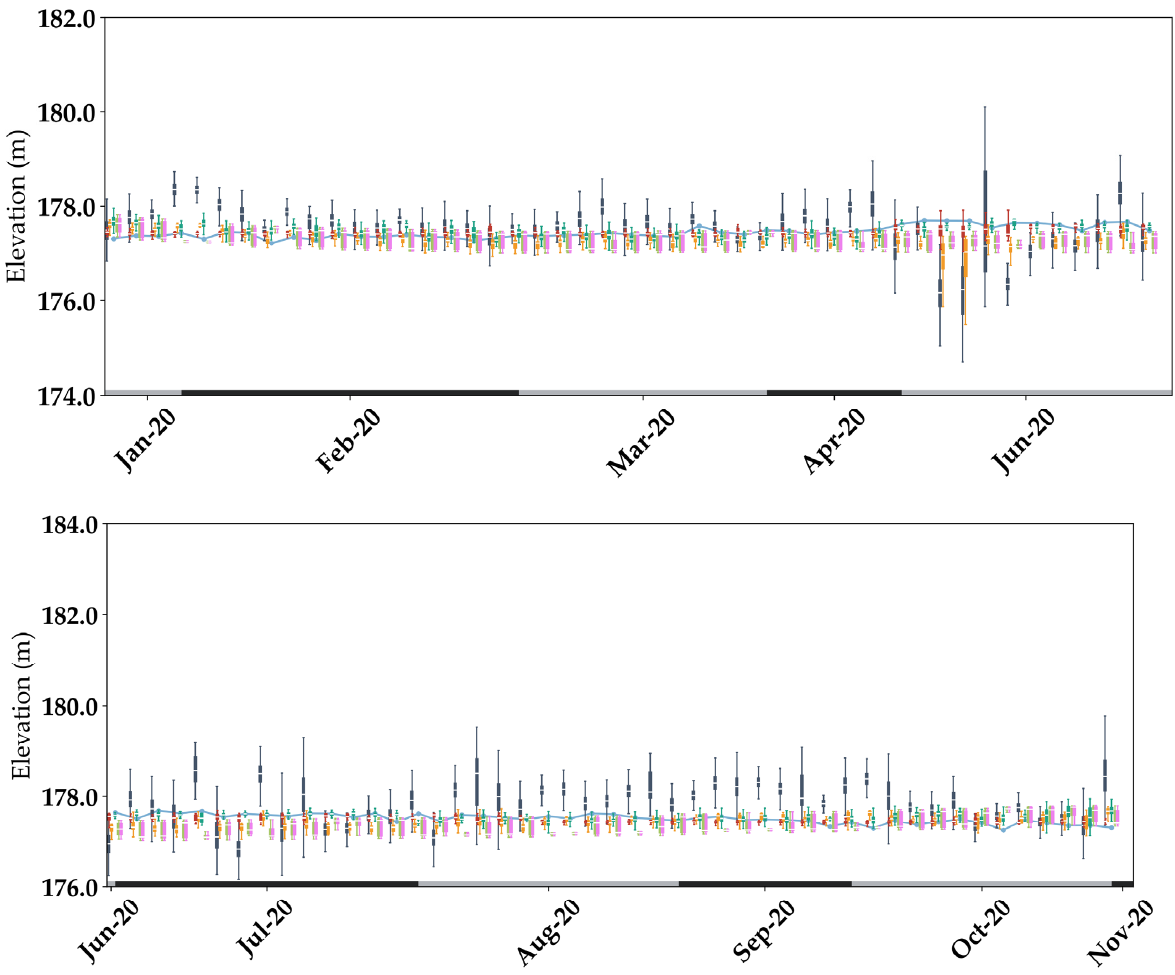
Figure A9. Boxplot by track of the original estimated elevations by GEDI over Lake Michigan and the five tested models presented in Section 3.1.3. The green line represents in situ elevations. RF CV represents the 5-fold cross-validation results over Lake Michigan. RF Erie → Michigan , RF Huron → Michigan , RF Ontario → Michigan , and RF Superior → Michigan represent the results of the models trained over Lakes Erie, Huron, Ontario, and Superior, respectively, and applied over Lake Michigan.